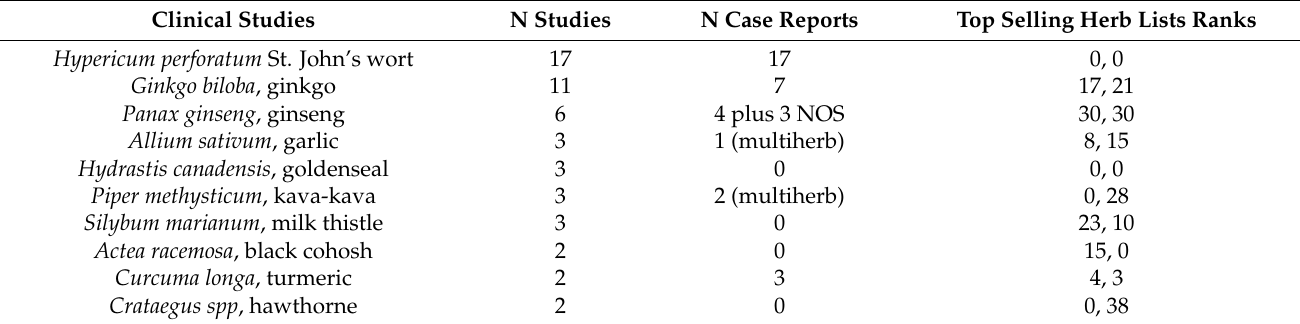
Table 3. Frequency of herb study compared to frequency of case report and rank on two top selling herb lists. NOS, species not otherwise specified, multiherb, identified only as a component in a case involving multiple herbs.